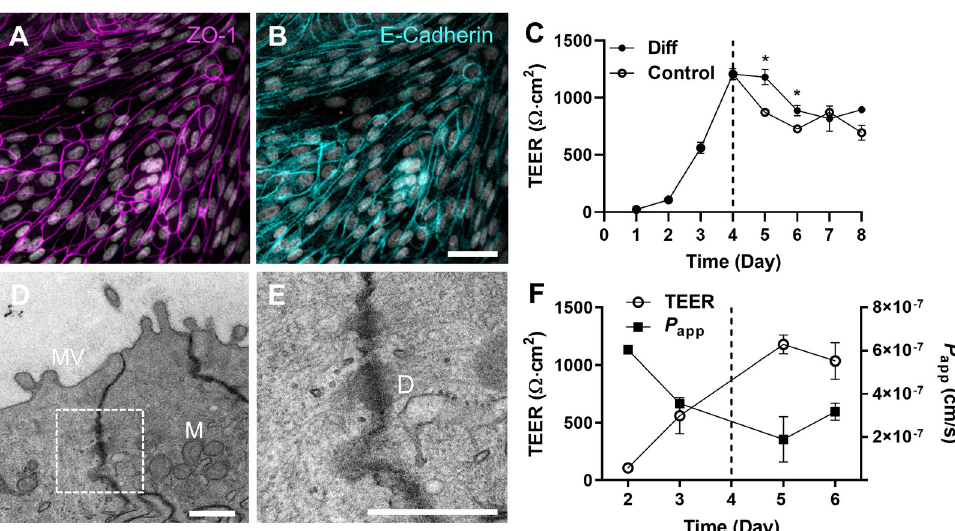
Fig 6. Characterization of the junctional proteins and the barrier function in the canine colonoid-derived epithelial monolayer. Visualization of the spatial localization of the ZO-1 ( A ; Magenta) and E-cadherin ( B ; Cyan) on the same location of a canine colonoid-derived monolayer. Nuclei, Grey. Bar, 50 μ m. ( C ) The profile of the epithelial barrier function was monitored by measuring TEER. The effect of culture medium on TEER was demonstrated by applying the regular proliferation medium in both the apical and basolateral side of the Transwell (Control, open circle) versus the differentiation/proliferation medium in the apical/basolateral compartments, respectively (Diff; closed circle). Both groups were cultured with the proliferation medium by Day 4 (a dashed line), then different culture media were applied (Diff vs. Control) for additional 4 days. Two biological replicates with 4 technical replicates were used in each condition. � P < 0.01. ( D ) A TEM image of the intercellular junctional complex in the canine colonoid-derived monolayer and a zoom-in ( E ) that shows a high-power magnification of the white dashed area in D . MV, microvilli; M, mitochondria; and D, desmosome. Bars, 500 nm. ( F ) The profile of TEER (open circle) and corresponding apparent permeability ( P app ) of fluorescein (closed square) on the days of 2, 3, 5, and 6 of the cultures. Each data point was prepared with 2 biological and 4 technical replicates. Error bars indicate